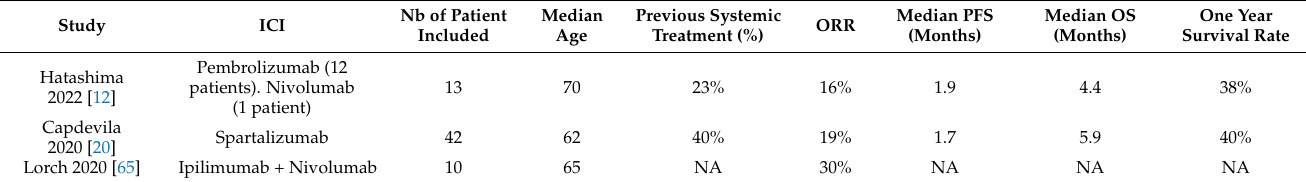
Table 1. Studies evaluating immunotherapy in anaplastic thyroid cell